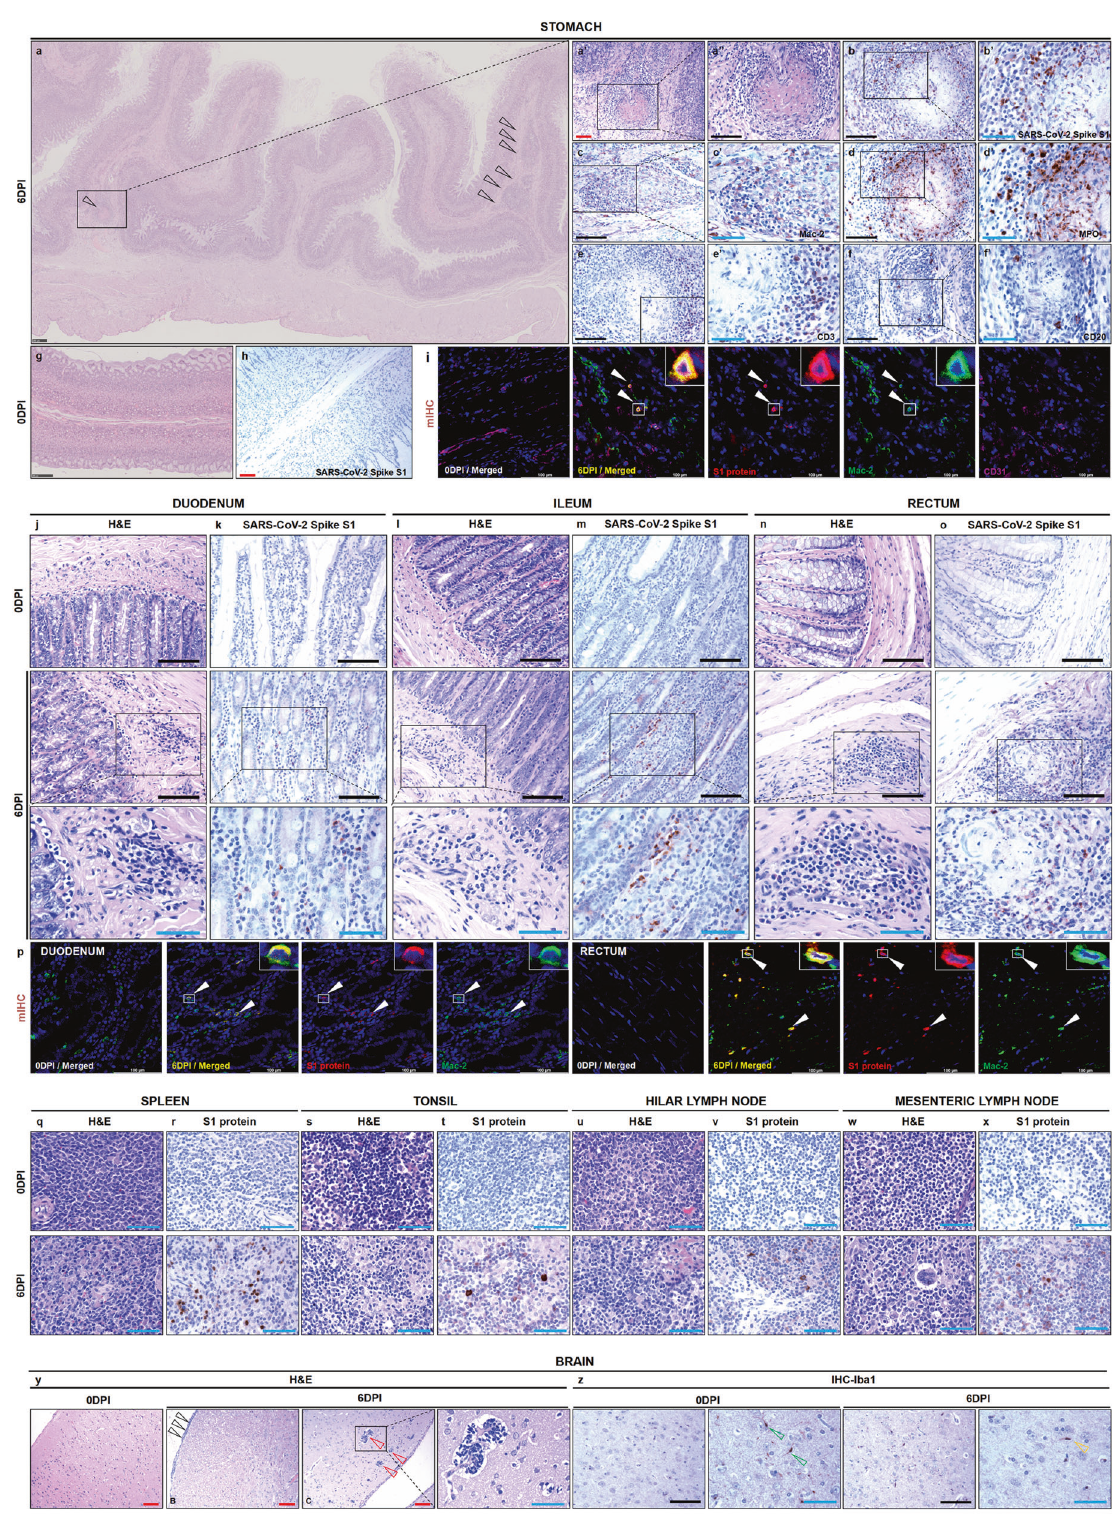
Lipidomic and metabolomic pro fi ling of sera of SARS-CoV-2- infected minks As lipids and metabolites are important molecular constituents in body sera contributing to physiology and pathology, we performed widely targeted lipidomic and metabolomic analyses of sera from animals from the control, 4-dpi, and 6-dpi